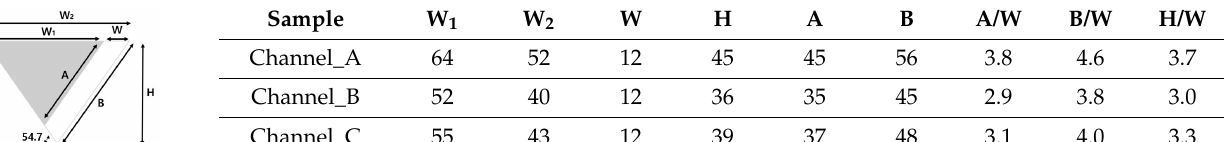
Figure 1. ( a ) Schematic view of the developed microfluidic device comprising a middle intercon- necting channel with an asymmetric cross-section in the T-junction region, ( b ) Design parameters for the HTWR trapezoidal channel with the asymmetric cross-section.